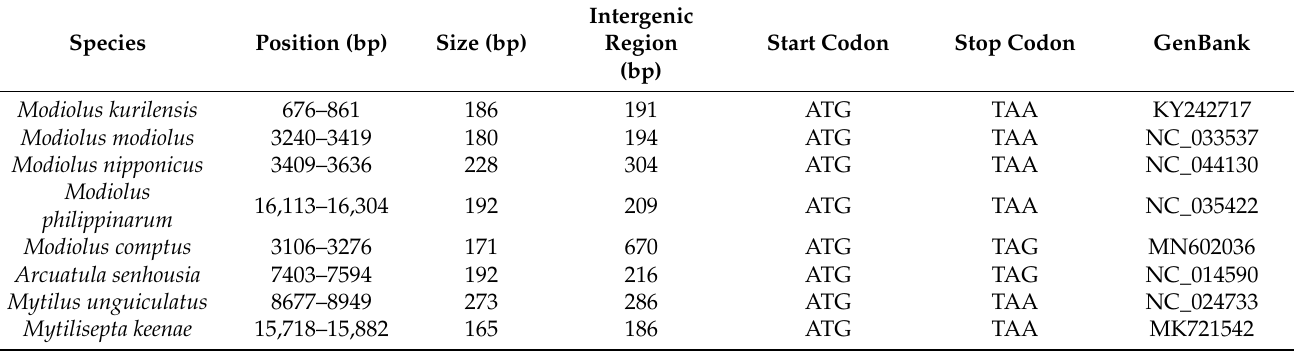
Table 4. Annotation of atp8 gene in